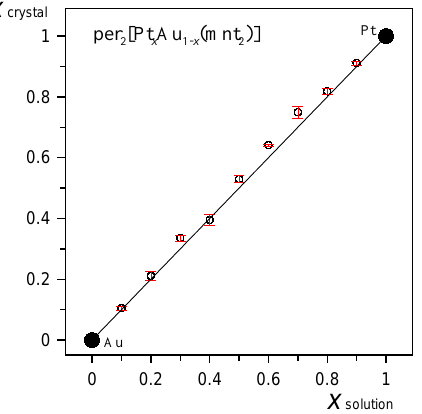
Figure 1. Pt and Au concentration of crystals (Per) 2 [Pt x -Au (1 − x ) (mnt) 2 ] versus growth solution concentration. The line represents a linear relation with equal solid and liquid concentrations.